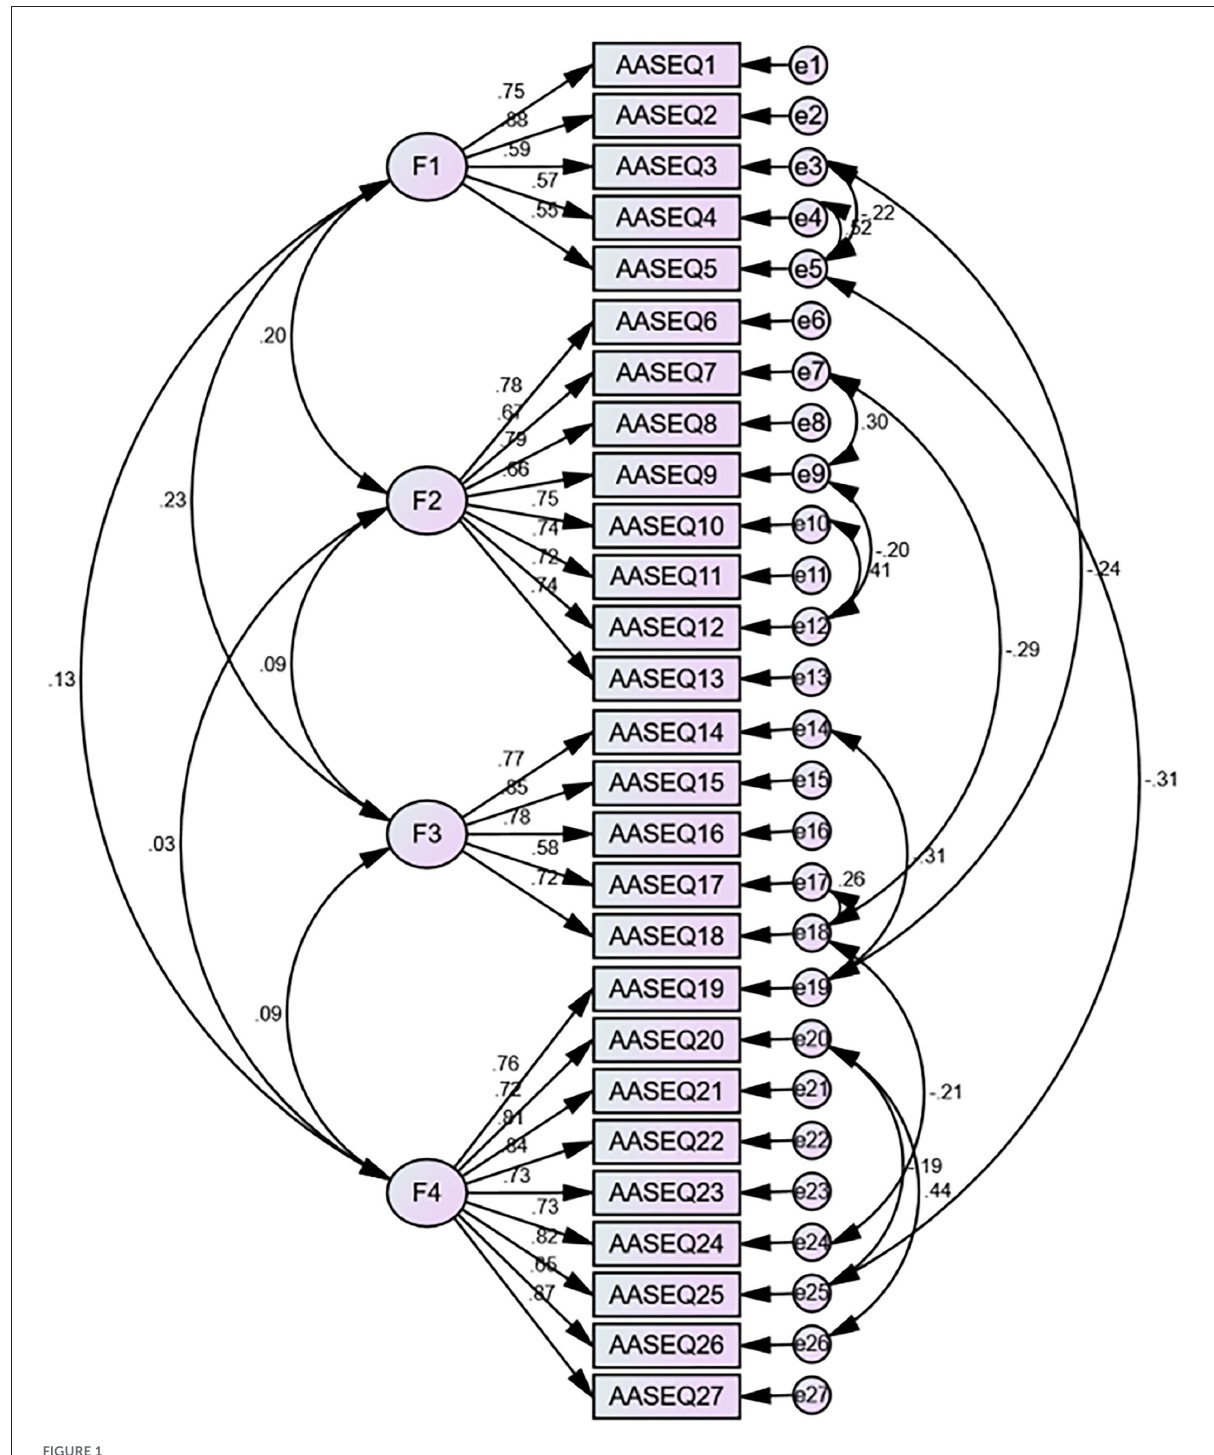
FIGURE1 The structure of